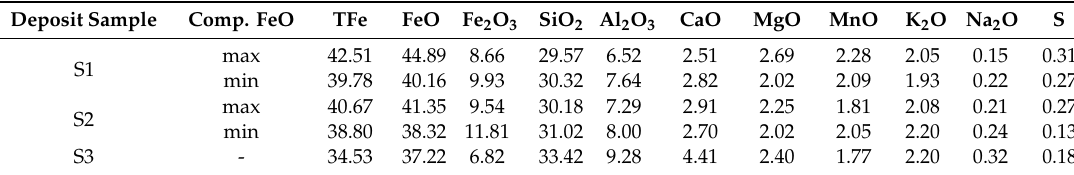
Table 4. Chemical compositions of deposit samples